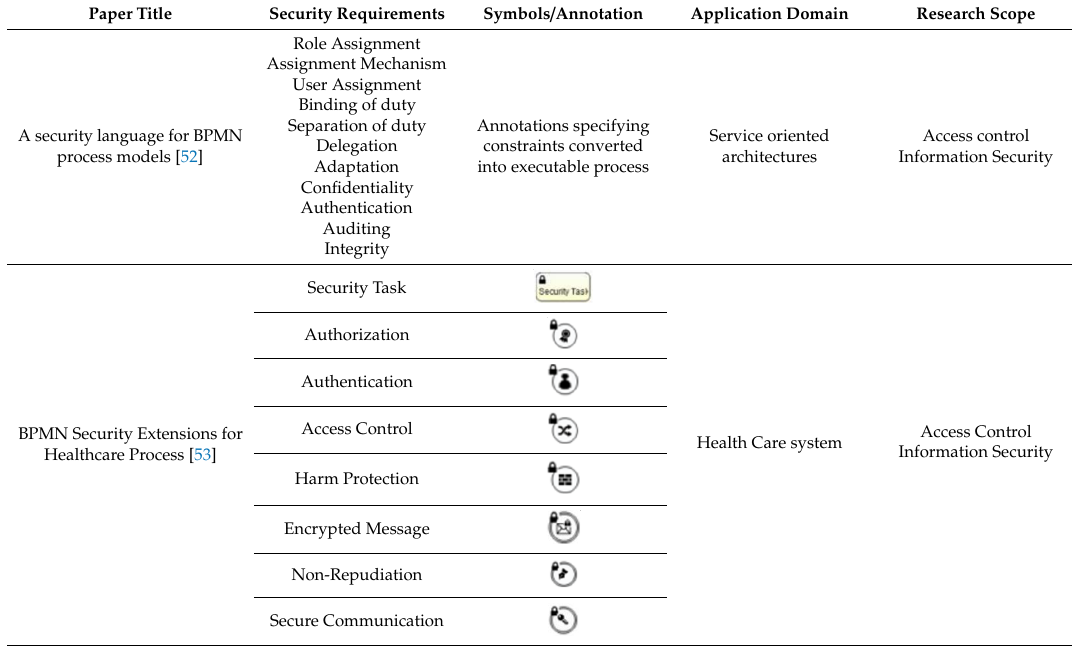
Table 2. Summary of existing Secure Business Process Management Notation (BPMN)